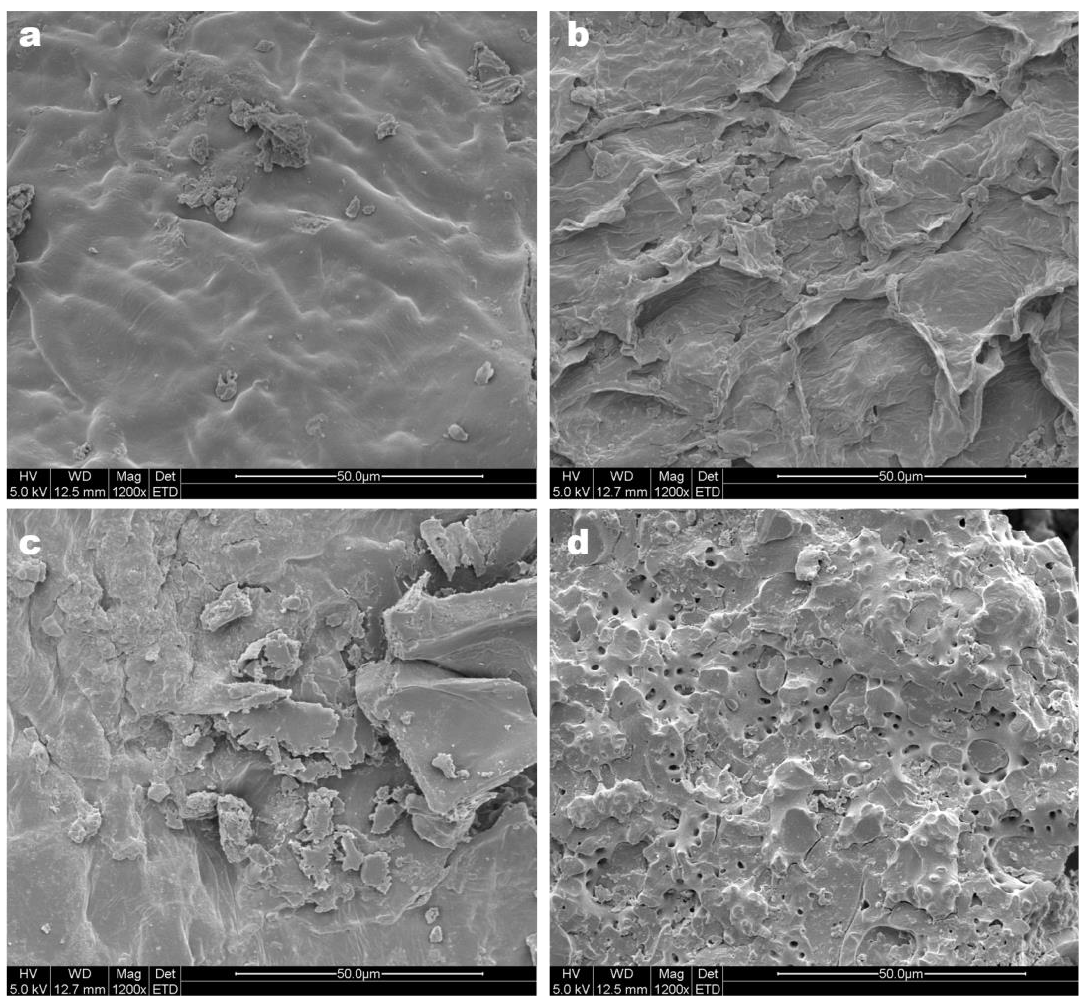
Figure 1. SEM observation of ( a ) the control treatment (CrBL-EO C2 ); ( b ) pre-enzymolysis treatment (CrBL-EO E2 ); ( c ) ultrasound–microwave treatment (CrBL-EO US2 c); and ( d ) pre-enzymolysis and ultrasound–microwave treatment (CrBL-EO EUS2 ). Table 3. DPPH • -SA (%) and ABTS • + -SA (mM Trolox) of the CrBL-EO treatments with IR% compared with the control treatment (CrBL-EO C2 ).